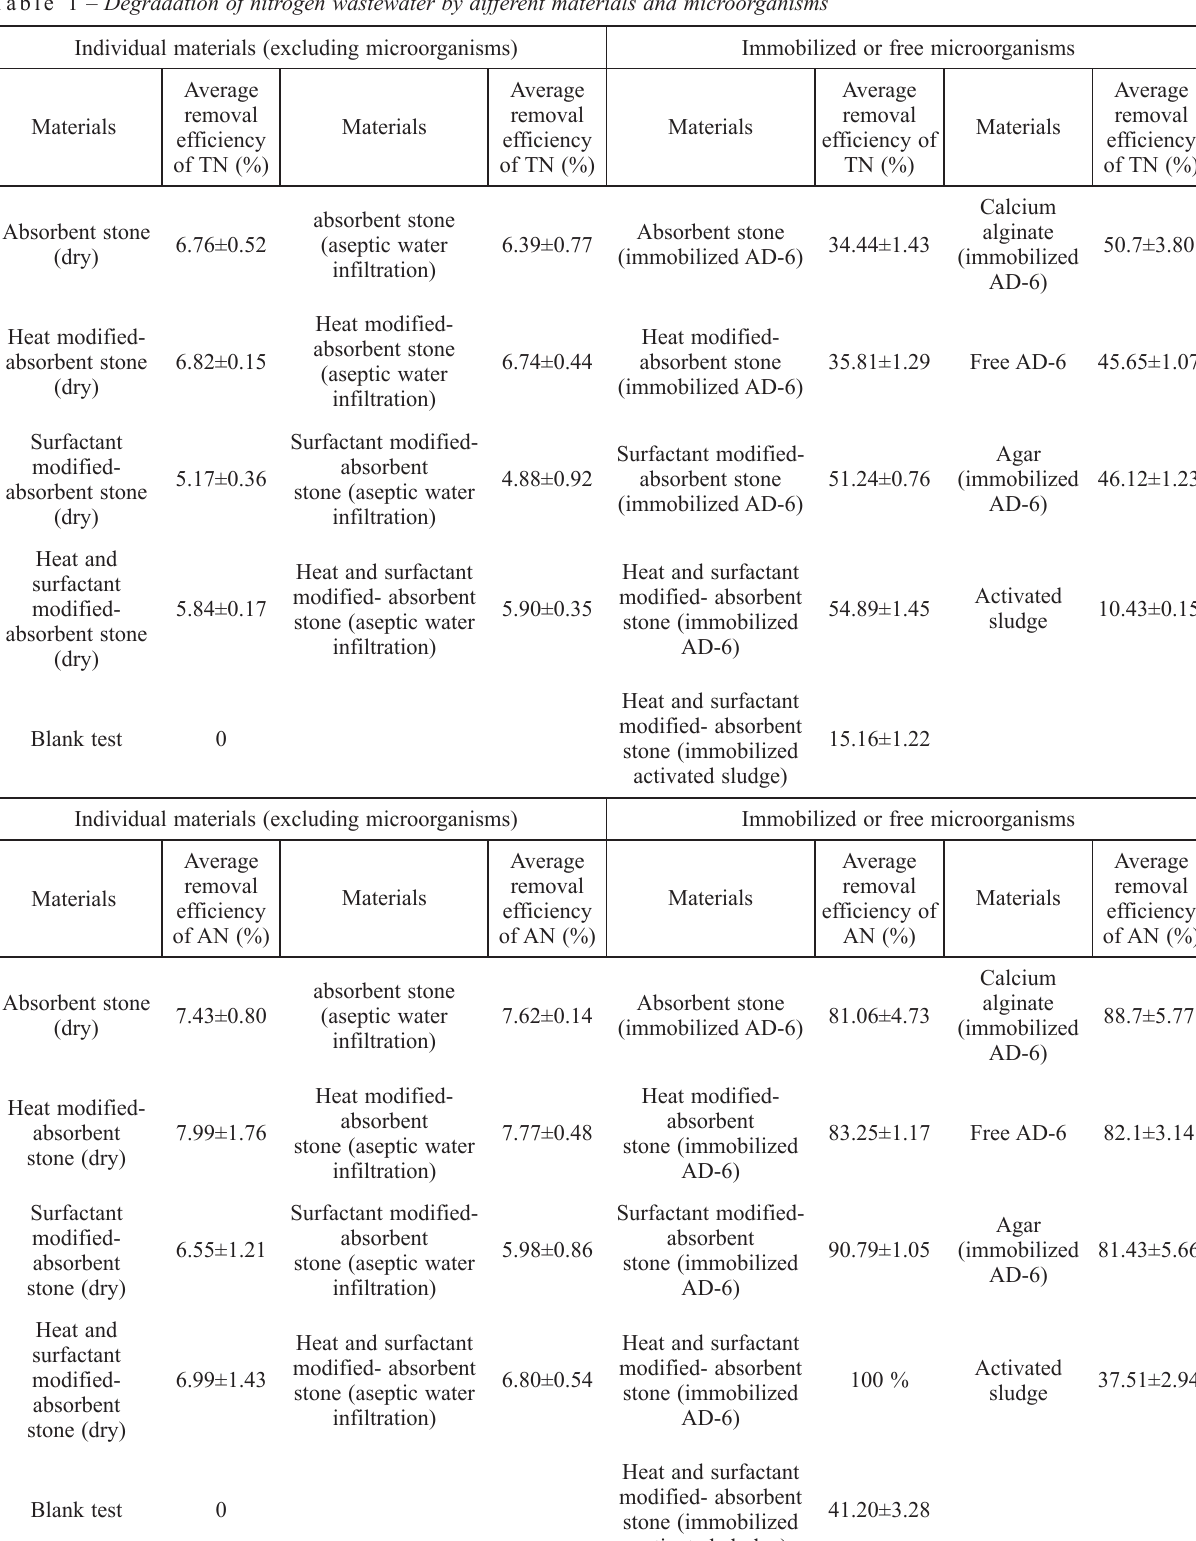
Table 1 – Degradation of nitrogen wastewater by different materials and microorganisms Individual materials (excluding